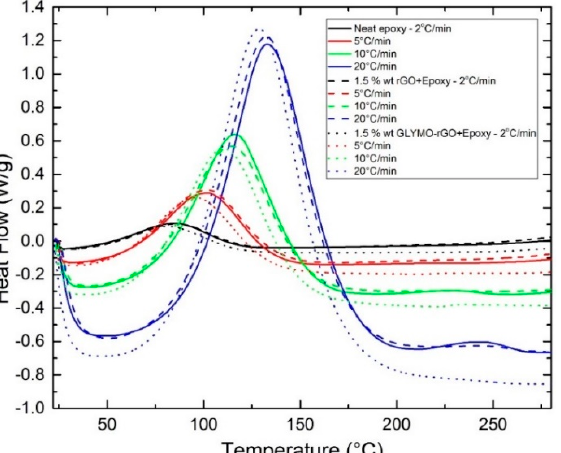
Figure 7. Dynamic scans with different heating rates 2, 5, 10 and 20 °C/min, for neat epoxy and nanocomposites with 1.5 wt% rGO or 1.5 wt% GLYMO-rGO. The results obtained for the initial cure (or onset) temperature ( T init ), peak cure tem- perature ( T p ), final cure temperature ( T final ), ultimate heat of curing ( ∆ H ult ) and degree of